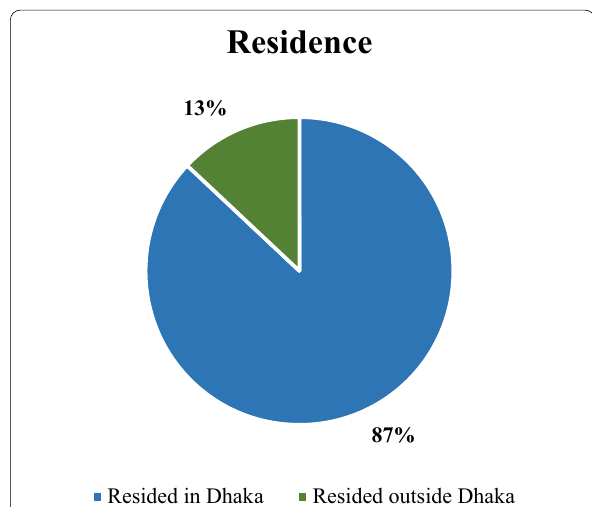
Fig. 1 Residence-wise distribution of dengue patients